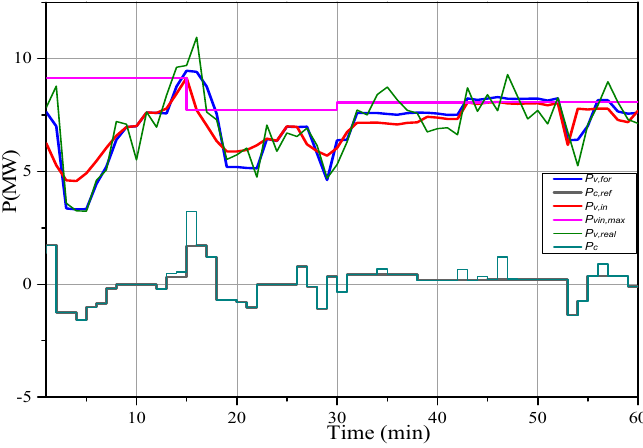
Figure 8. Results of UC control and real-time adjustment.